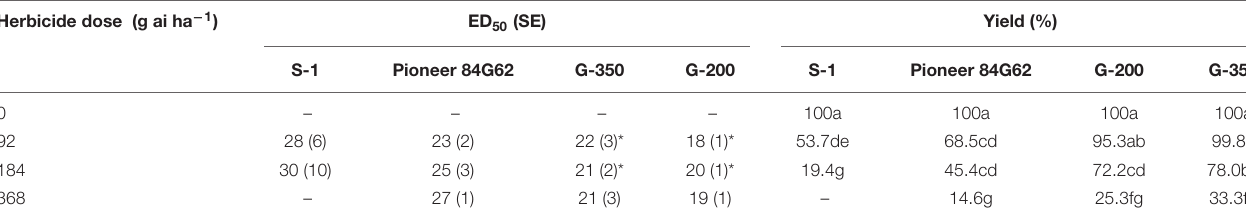
TABLE 2 | Recovery (ED 50 ) and single plant yield (% of non-treated) in response to different doses of tembotrione under field conditions (ED 50 : days required for 50% recovery). Herbicide dose (g ai ha − 1 ) ED 50 (SE) Pioneer 84G62